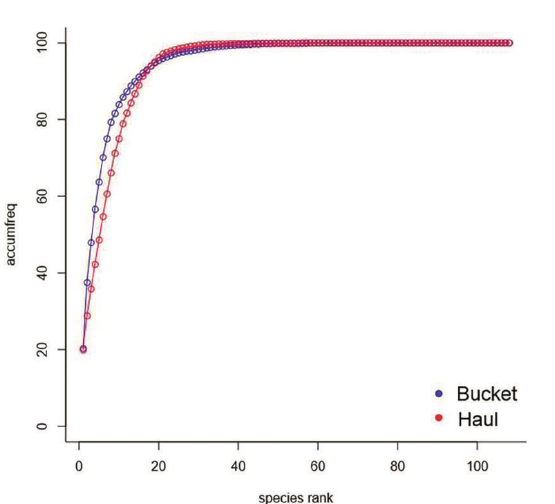
Figure 3 - K-dominance plot of zooplankton collected from Ribeirão das lajes Reservoir from May/2011 to June/2012 using the two strategies. Accumulative frequency/y-axis and species rank/x-axis. The circles in the curves resent the rank in ascending order of abundance representativeness.